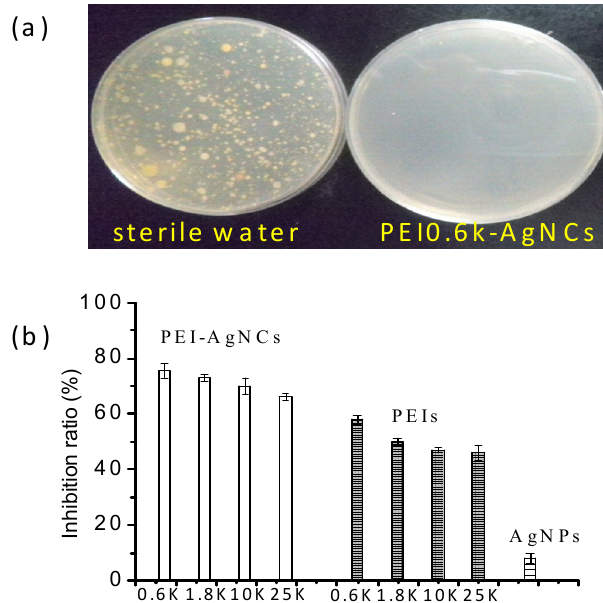
Figure 5. The strong antibacterial activities of PEI-AgNCs. ( a ) Photographs of E. coli colonies on broth agar plates in the presence of sterile water and 7.81 mg/mL PEI0.6k-AgNCs. It seems that the sterile water or E. coli suspension used for the experiment was contaminated by other bacteria, but it has no effect on verifying the MICs of PEI-AgNCs; ( b ) The inhibition ratios of PEI-AgNCs, PEIs and AgNPs, which were calculated according to Equation 1.